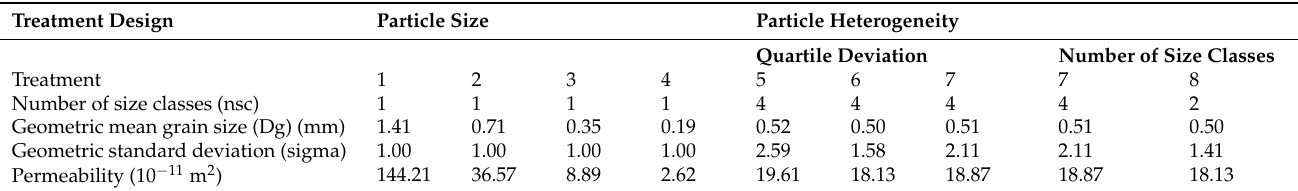
Table 1. Experimental treatment designs to test effects of particle size and heterogeneity on permeable sediment denitrification. Treatment